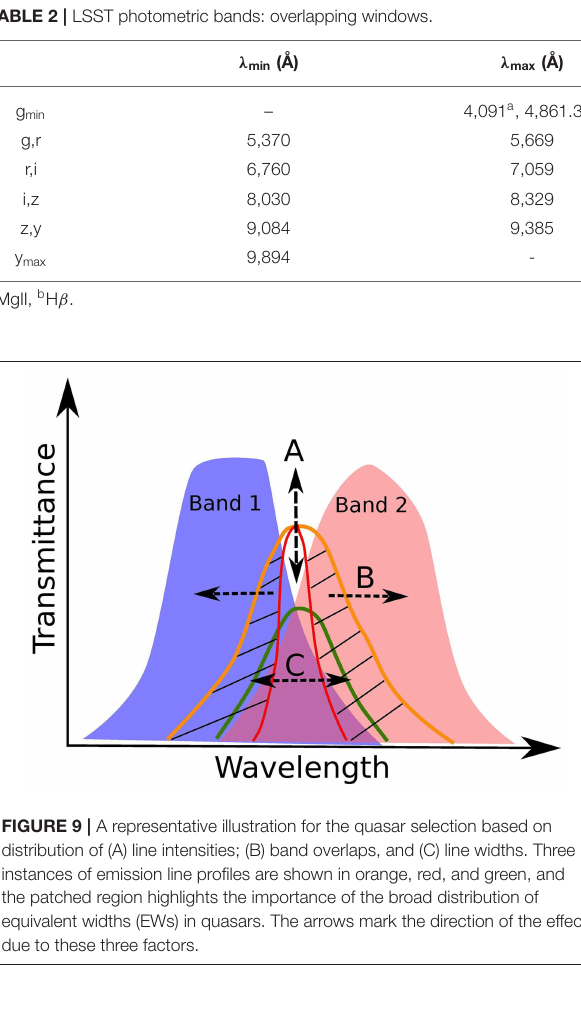
the throughput value, T band. In the case for H β , the starting value z